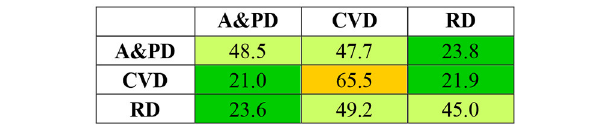
FIGURE 3 | Heat map of percentage of common patents between pharmaceutical domains. Alzheimer’s and Parkinson’s disease (A and PD), cardiovascular disease (CVD), and respiratory disease (RD). See Figure 2 for instructions to interpret the